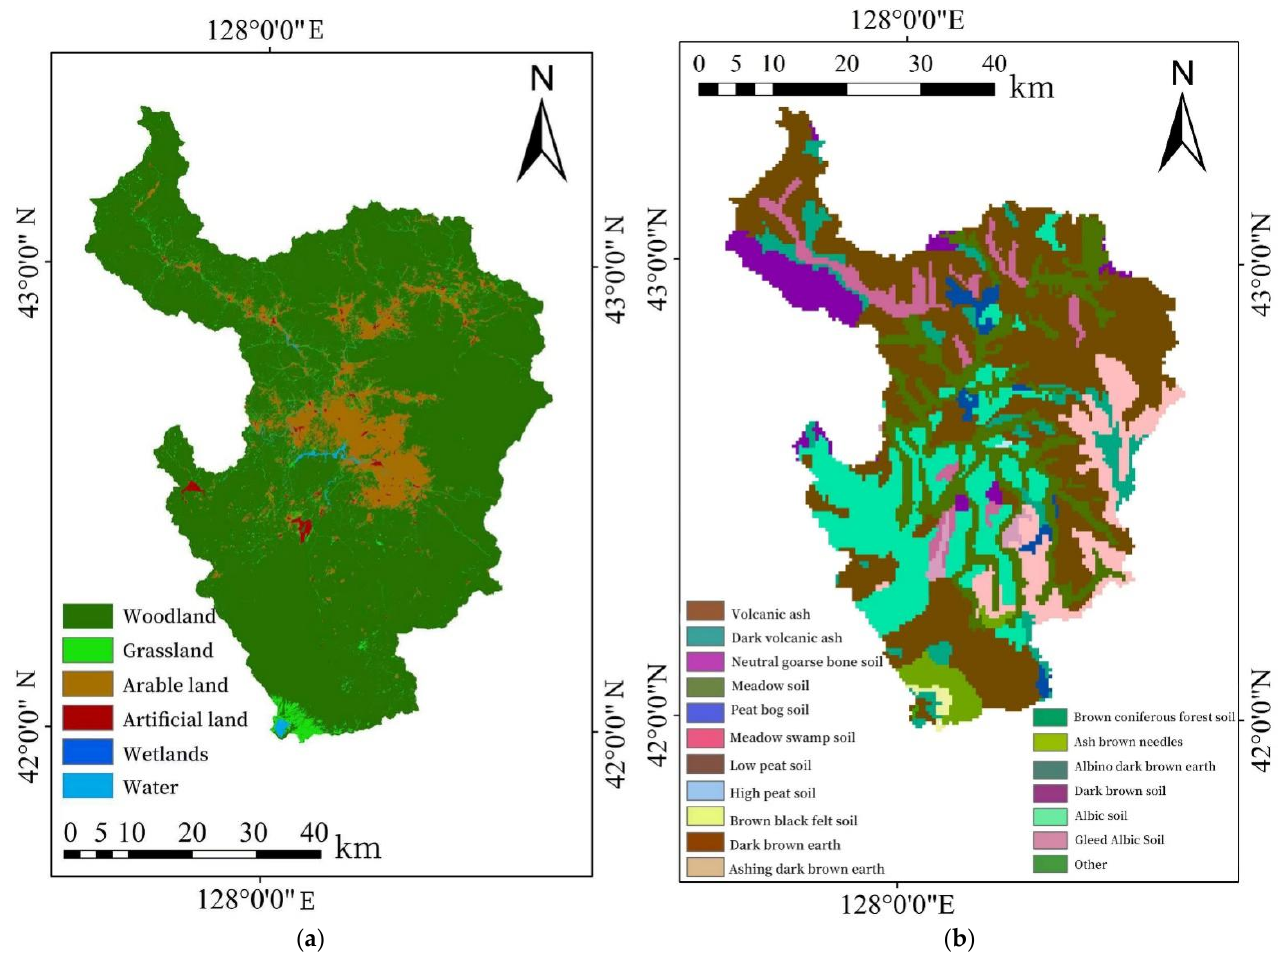
Figure 2. ( a ) Land use map of the study area. ( b ) Soil type map of the study